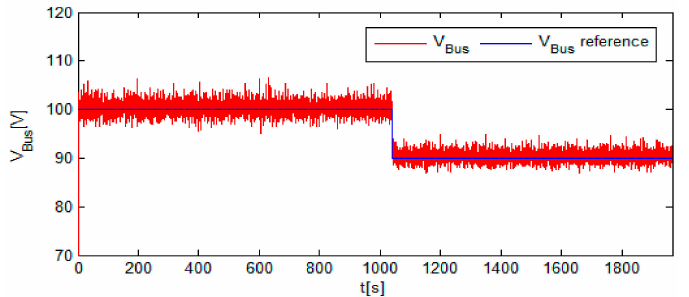
Figure 35. DC-link voltage control